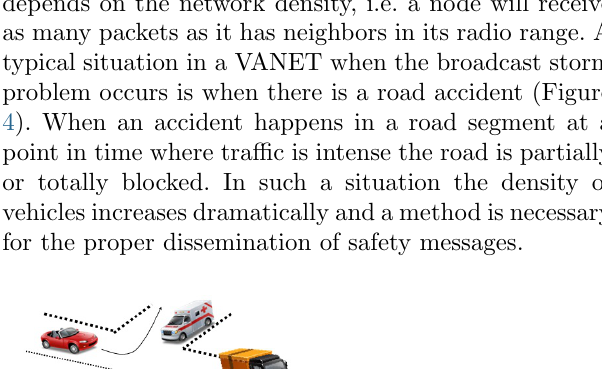
Algorithm 1: Social ranking of road